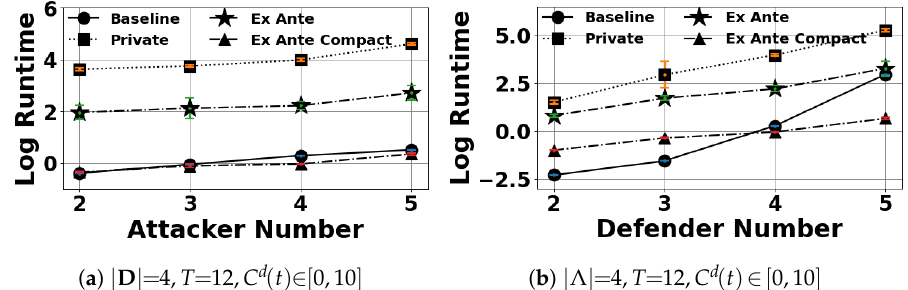
Figure A1. Log runtime performance.